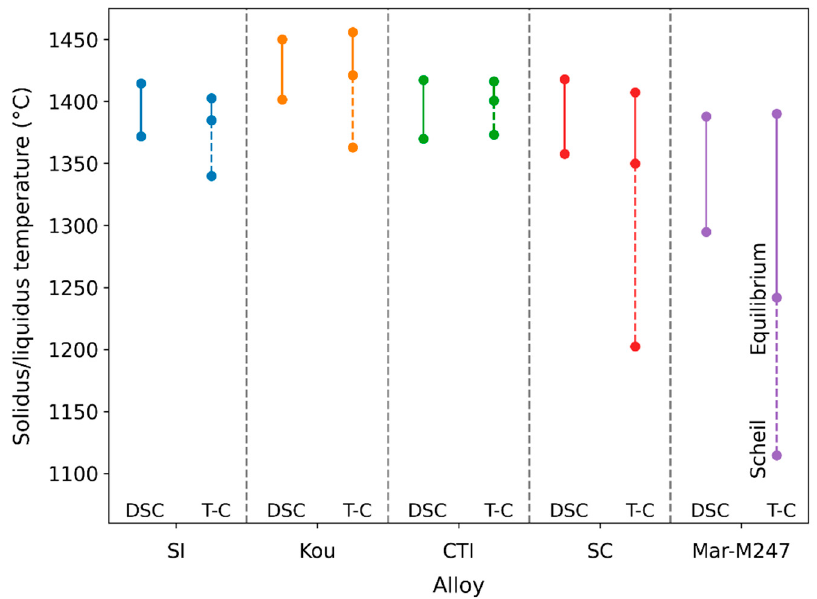
Figure 4. Solidus and liquidus temperatures measured with DSC and calculated with Thermo-Calc (T-C). Solidus temperatures were calculated in equilibrium and with Scheil solidification, where the temperature was determined at 95% solid phase fraction.